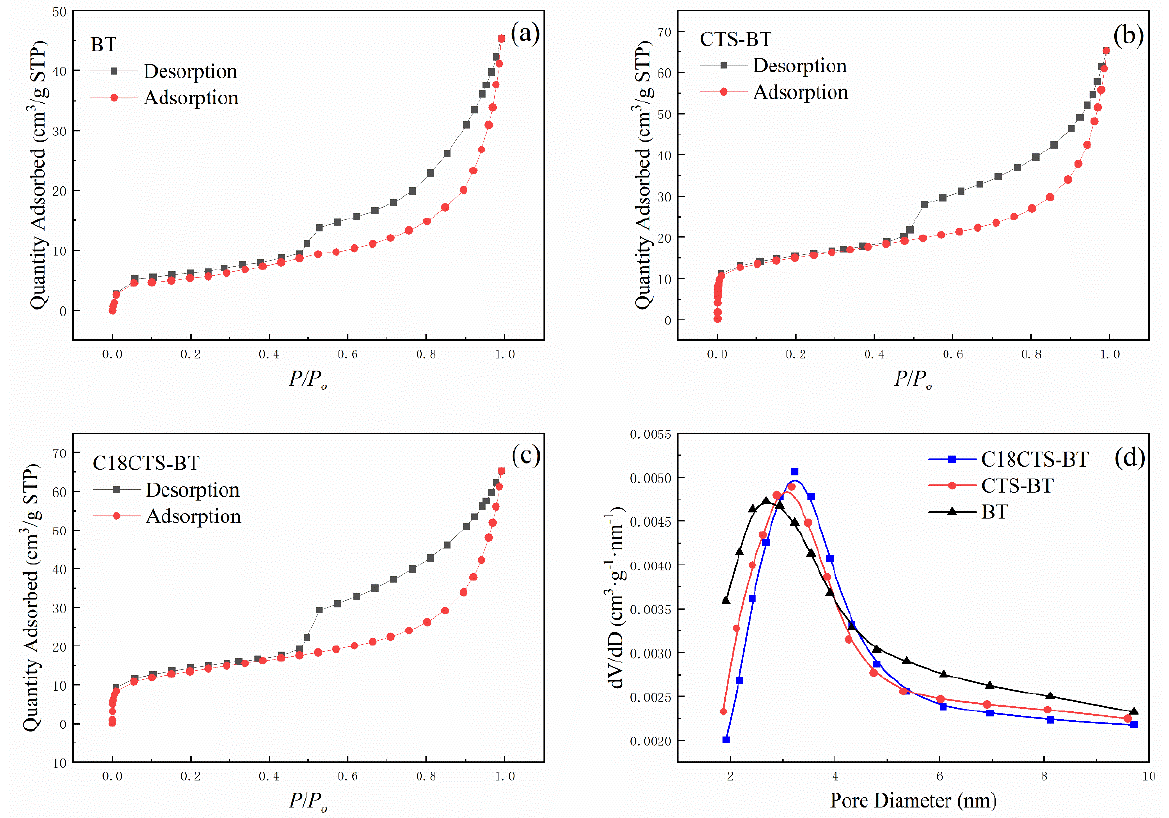
Figure 5. N 2 adsorption–desorption isothermal curve and pore size distribution curve of the adsor- bents (( a – c ) show the N 2 adsorption–desorption isothermal curves for BT, CS–BT and C18CS–BT, respectively; ( d ) shows the pore size distribution curves for three different adsorbents).